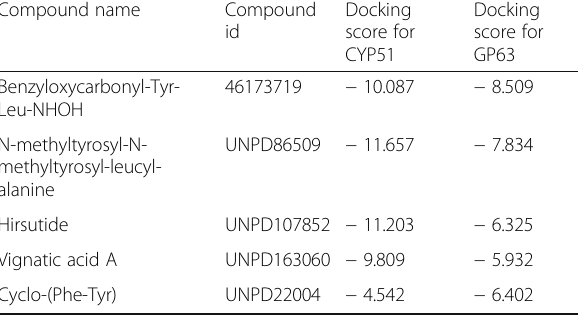
Table 2 Docking scores for validated Inhibitor and natural compounds with CYP51 and GP63 target